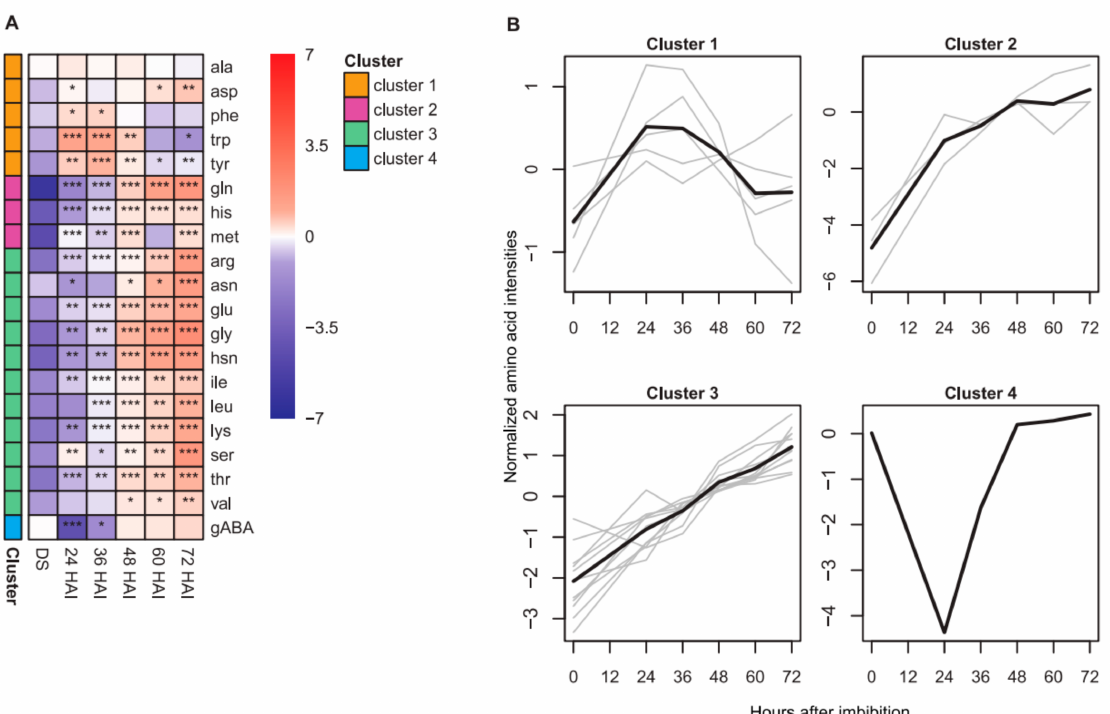
Figure 3. Amino acid levels in dry seeds (DS), germinating seeds and seedlings and their kinetic patterns. ( A ) Abundance of amino acids in DS, germinating seeds and seedlings collected at the indicated time points after imbibition. The color gradient represents mean concentration of amino acid (nmol/gDW) after log 2 transformation and median normalization ( n = 4). Levels of significance comparing the amino acids in germination seeds and seedlings to DS (unpaired two-sided t -test) are indicated by asterisks (* p < 0.05; ** p < 0.01; *** p < 0.001). Amino acids are listed alphabetically within their clusters (cluster 1–4) as determined by k-means clustering. Each cluster is indicated by a unique color. ( B ) Patterns of amino acid abundance as determined by k-means clustering. Gray lines represent individual metabolites while black lines show the mean of each cluster. gABA– γ -aminobutyric